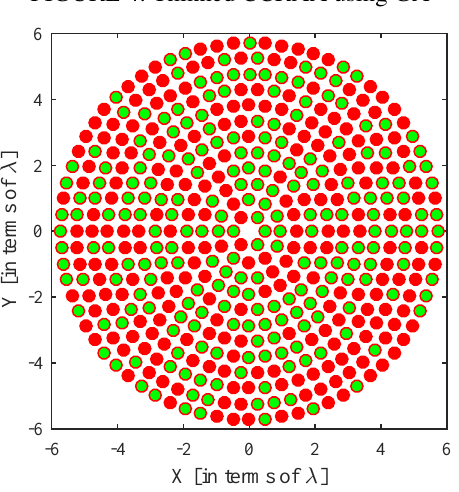
FIGURE 4: Thinned CCRAA using GA